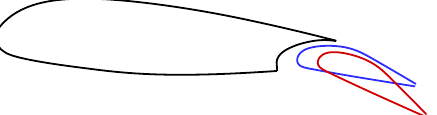
Figure 4. Flap deflections at Flap A ( ) and Flap B ( )